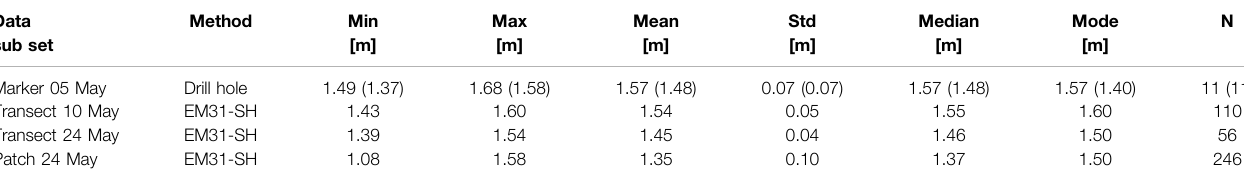
TABLE 2 | Drill hole ice thickness and draft (in brackets) at the marker locations and EM31-SH ice thickness. Std isthe fi rst standard deviation of the respective mean and N the number of measurements. The modes were read from histograms with 0.10 m bin